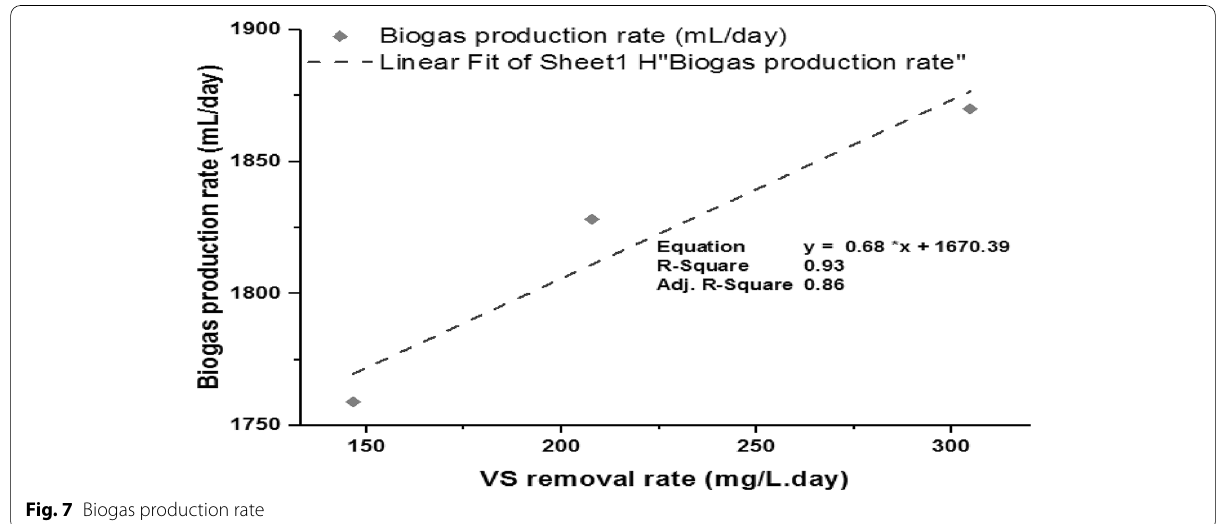
Fig. 7 Biogas production rate